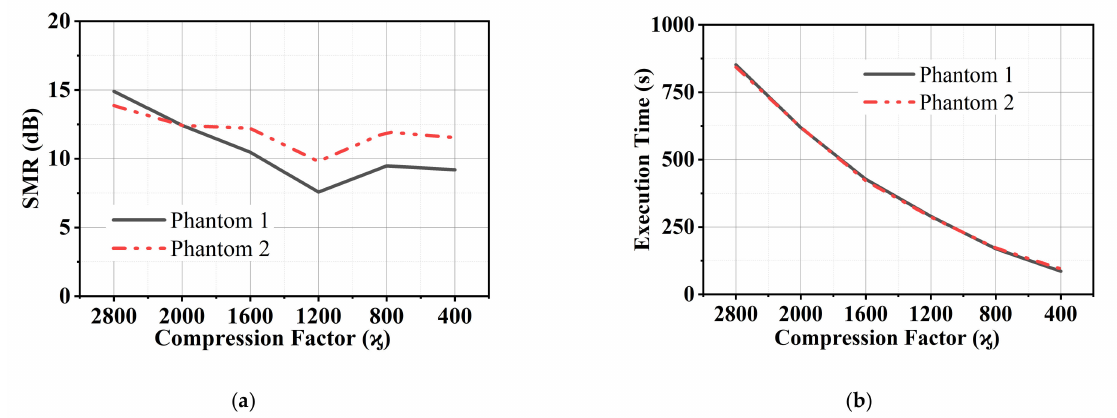
Figure 9. ( a ) SMR and ( b ) execution time with respect to the compression factor. Table 1. Signal-to-mean ratio and execution time against the compression factor.